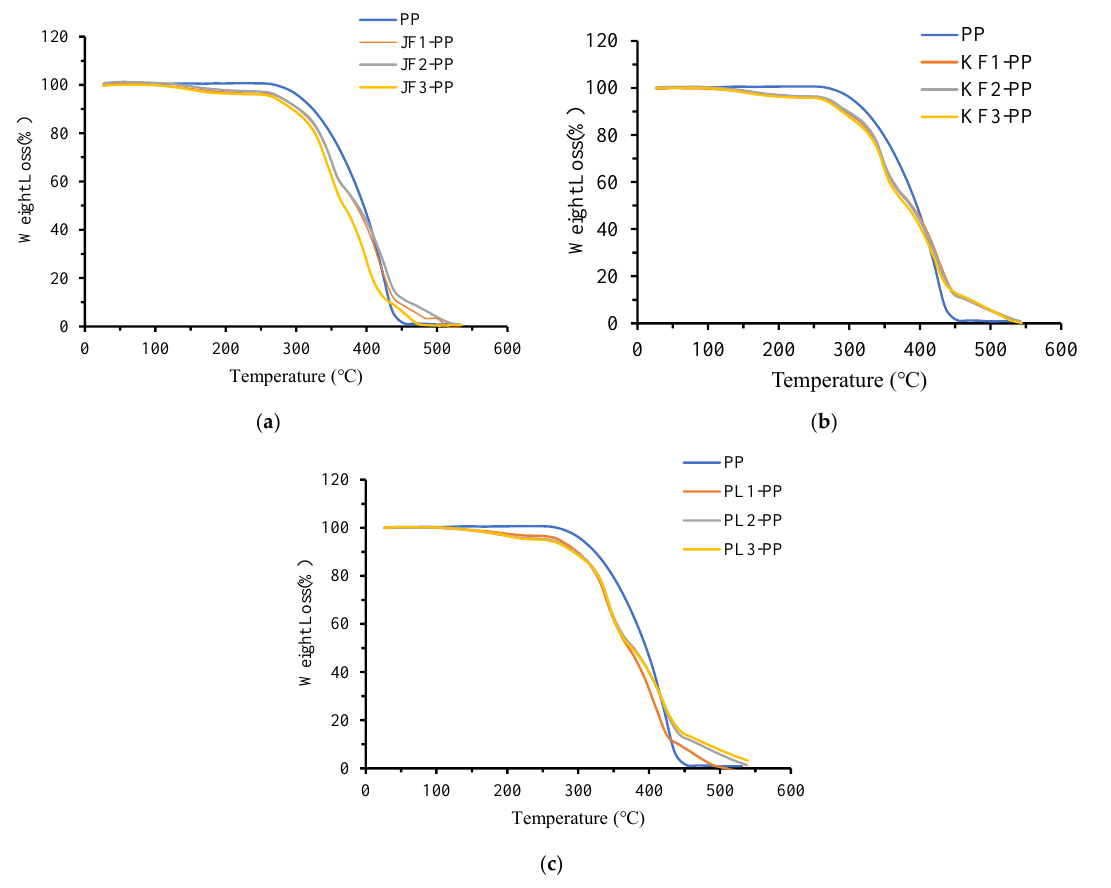
Figure 11. TGA curves of ( a ) jute, ( b ) kenaf, and ( c ) PLAF-PP composites at 30, 35, and 40 wt.% fiber loadings.